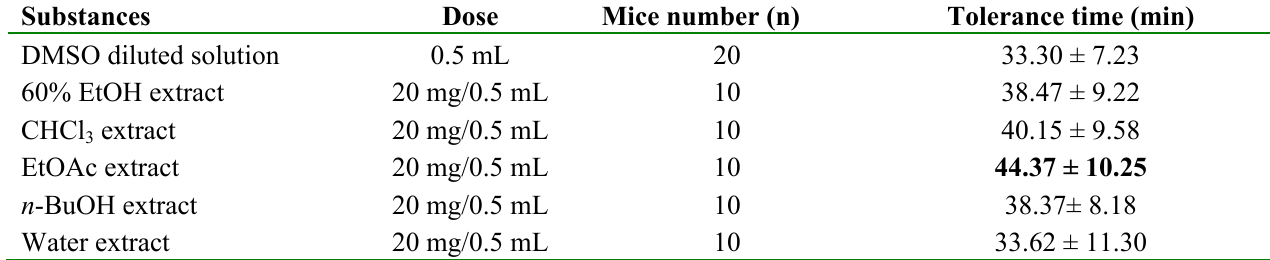
Table 2 . The tolerance time of mice administrated different extracts of Hypericum japonicum Thunb.